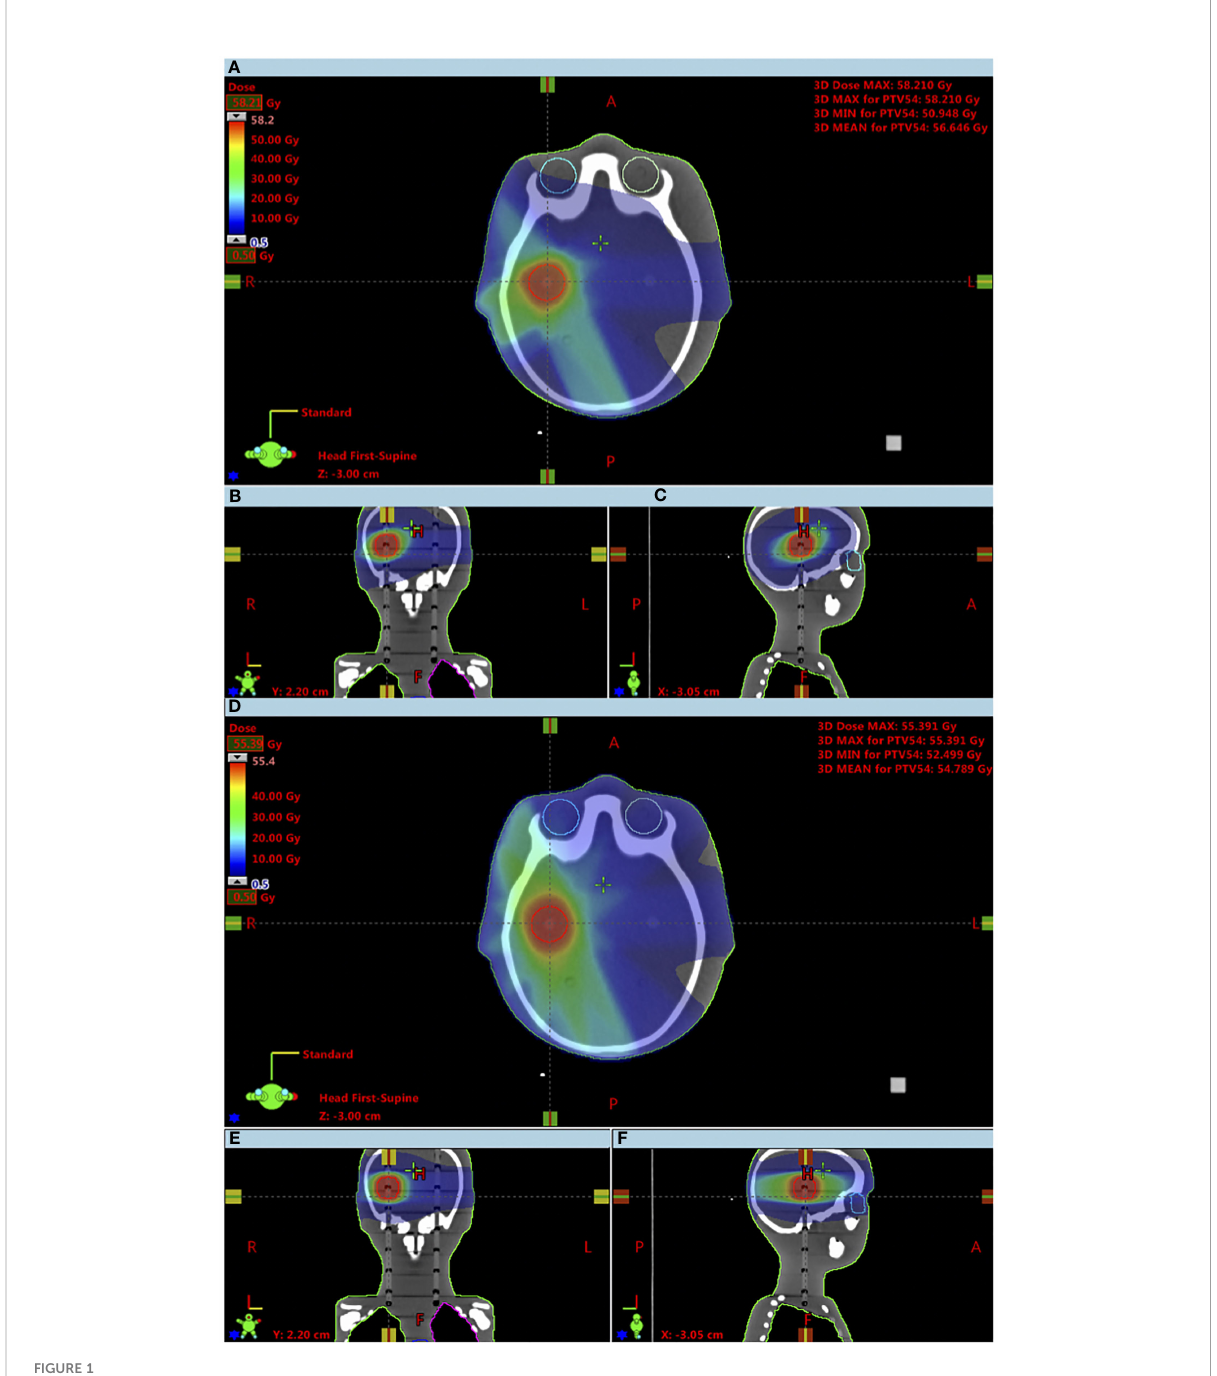
FIGURE 1 Comparison of obtained dose distributions between the 3DCRT and IMRT techniques up to a minimum dose of 500 mGy. (A) 3DCRT axial view; (B) 3DCRT coronal view; (C) 3DCRT sagittal view; (D) IMRT axial view; (E) IMRT coronal view; (F) IMRT sagittal